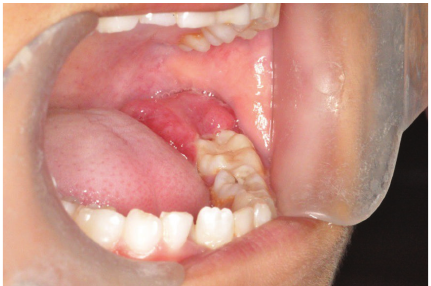
Figure 1: Intraoral picture showing growth in the lower left posterior region on lingual and distal aspect of 36.